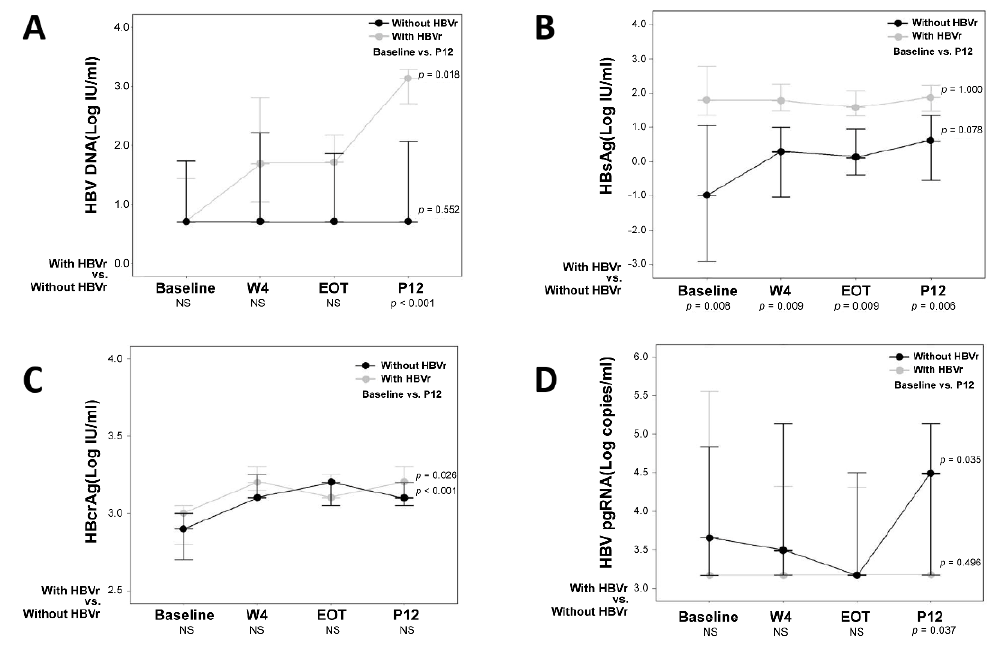
Figure 3. Expression of HBV DNA, HBsAg, HBcrAg, and HBV pgRNA with/without HBV reactiva- tion in HBV/HCV coinfected patients without nucleot(s)ide analogue treatment ( n = 31). ( A ) HBV DNA significantly increased from baseline to P12 in patients with HBV reactivation ( p = 0.018). The HBV DNA titer in patients with HBV reactivation was higher than those without HBV reactivation at P12 ( p < 0.001) ( B ) In patients with or without HBV reactivation, HBsAg has no significant change from baseline to P12. The patients with HBV reactivation had significantly higher HBsAg titers than